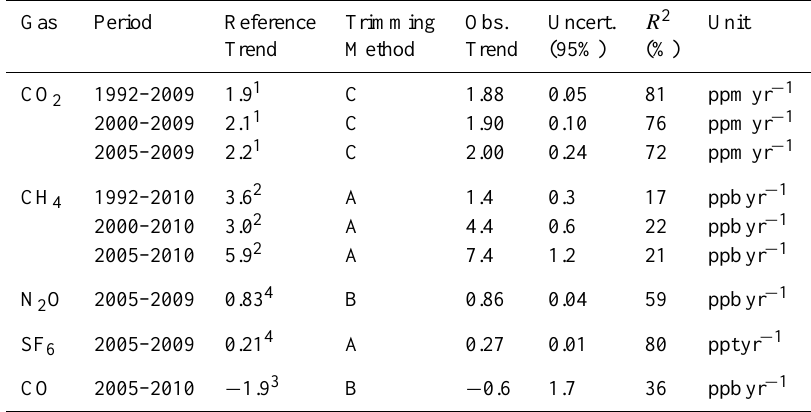
Table 6. Results of the multi-annual concentration trend analysis for CO 2 , CH 4 , N 2 O, SF 6 and CO based on the Cabauw 200m level concentration measurements. Correlation coefficient R 2 is based on the whole fit of Eq. (2), including trend and harmonic parameters. For explanation of the Trimming Methods used see text (Sect. 4.5). Gas Period Reference Trimming Obs. Uncert. R 2 Unit Trend Method Trend (95%) (%) CO 2 1992–2009 1.9 1 C 1.88 ppmyr −